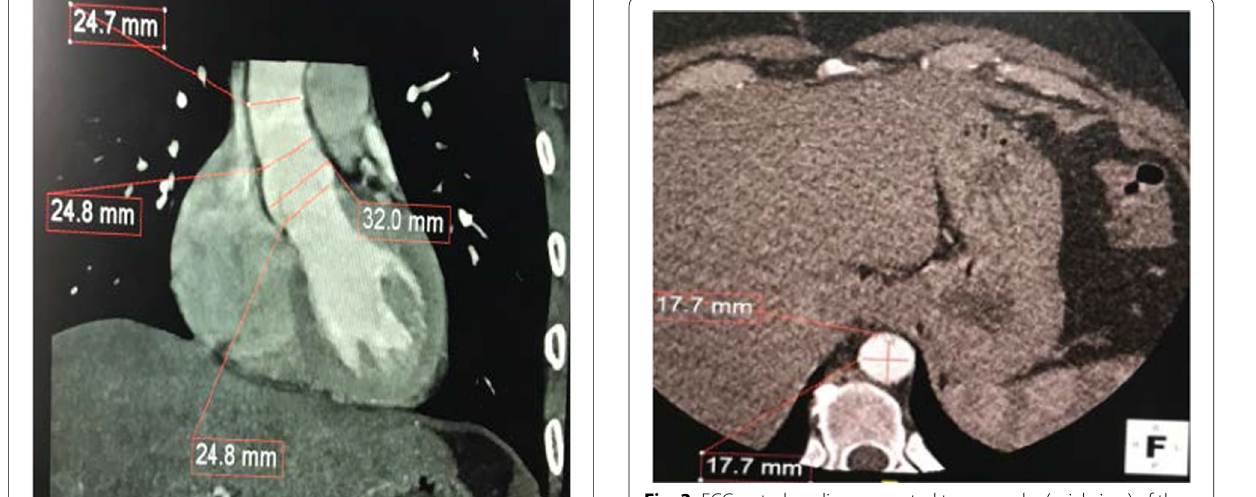
Fig. 3 ECG‑gated cardiac computed tomography (axial view) of the descending thoracic aorta at the level of the diaphragm in a